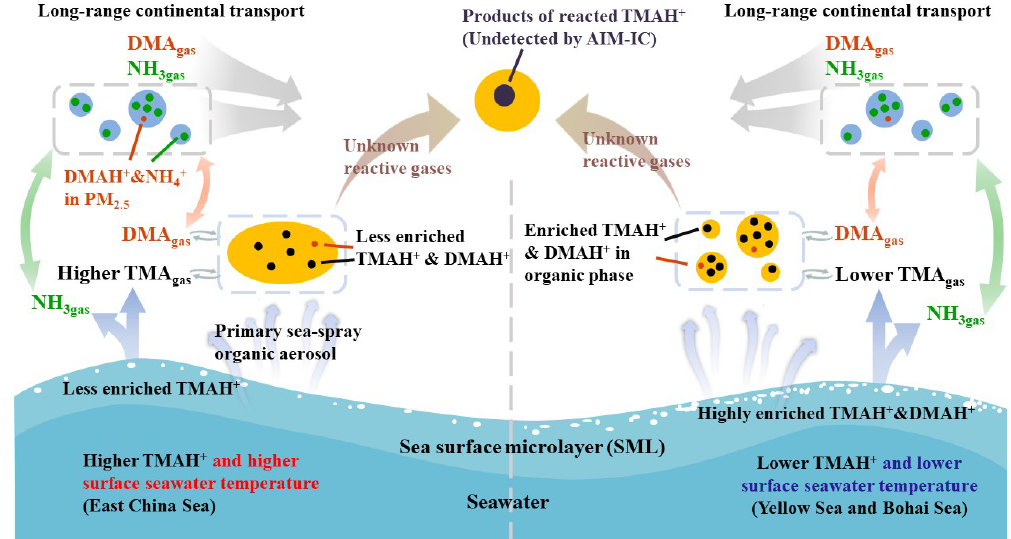
Figure 6. A schematic illustrating the release of basic gases and their counterparts from the two different seas and potential atmospheric